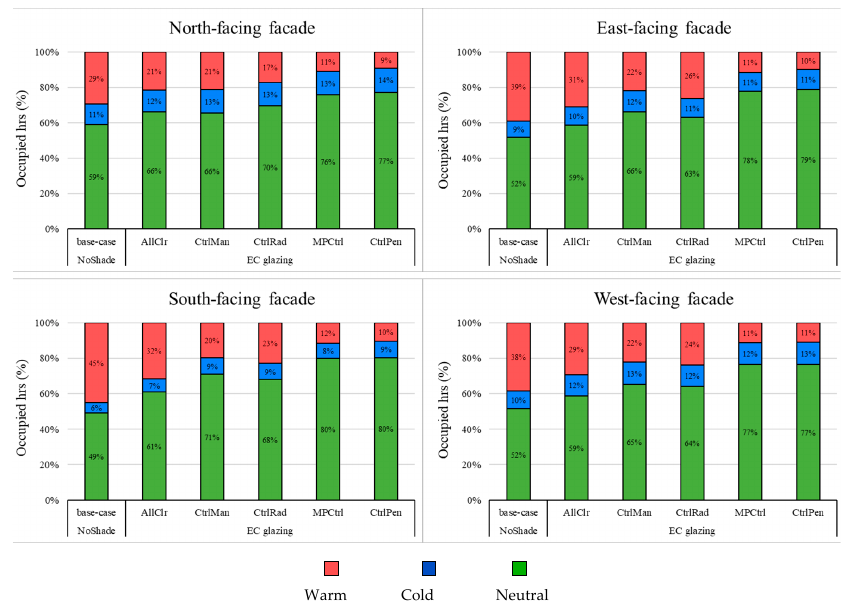
Figure 10. The overall performance of the EC glazing system in terms of thermal comfort for different orientations results for occupants closer to the façade (G1). The results for thermal comfort clearly show that using EC glazing improves providing thermal comfort for all orientations, particularly by using an automatic control.